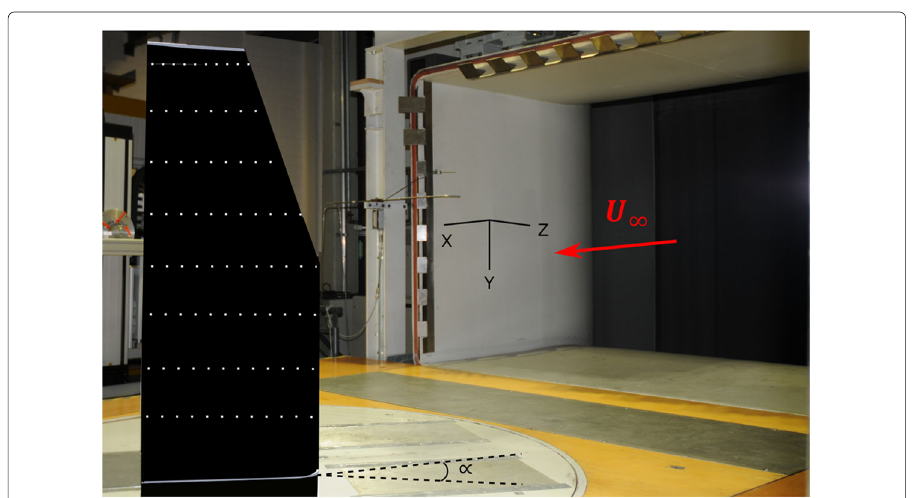
Fig. 2 Elasto-flexible membrane wing model mounted in the test section of wind tunnel A